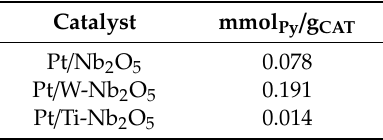
Figure 5. Fourier-transform infrared (FT-IR) spectra of pyridine recorded after evacuation at 150 °C (L = Lewis acid site band; B = Brønsted acid sites band) and normalised by the disk weight. (a) Pt/W- Nb 2 O 5 , (b) Pt/Nb 2 O 5 and (c) Pt/Ti-Nb 2 O 5 . Table 3. Amount of adsorbed pyridine on Lewis site.